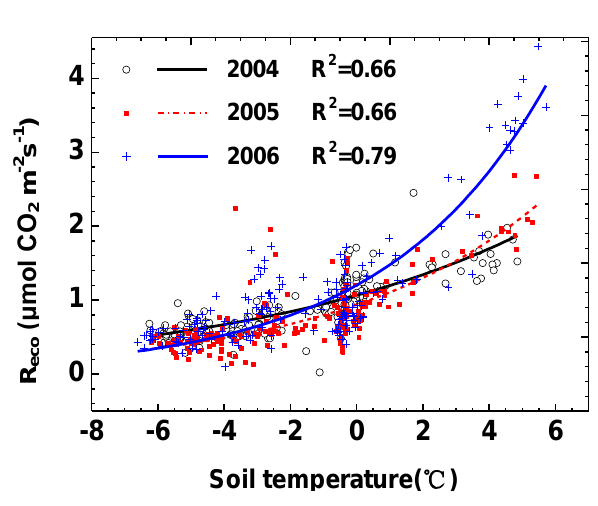
Fig. 3. Response of ecosystem respiration ( R eco ) to variety of soil Fig. 3 Response of ecosystem respiration ( R eco ) to change in soil temperature at the depth of 5 cm temperature at the depth of 5cm during non-growing season. Data were half-hourly under high turbulence conditions ( u ∗ > 0 . 1ms − 1 ) from 2004 to 2006. during non-growing season. Data were half-hourly under high turbulence conditions (u*>0.1ms - 1 )from 2004 to 2006. 3.5 Influence of rain events on non growing R eco Small pulses of R eco were observed immediately after in- dividual rain events during the non-growing period. Data Fig. 7. The rain event I occurred on 9 October 2004, with total precipitation of only 1.7 mm/day (Fig. 7). On Octo- ber 11, R eco suddenly decreased to 4.74 g C m − 2 per day from the background level of 8.70 g C m − 2 per day observed a few days ago. Then after two days, R eco increased to 7.25 g C m − 2 per day, as observed on 13 October. After